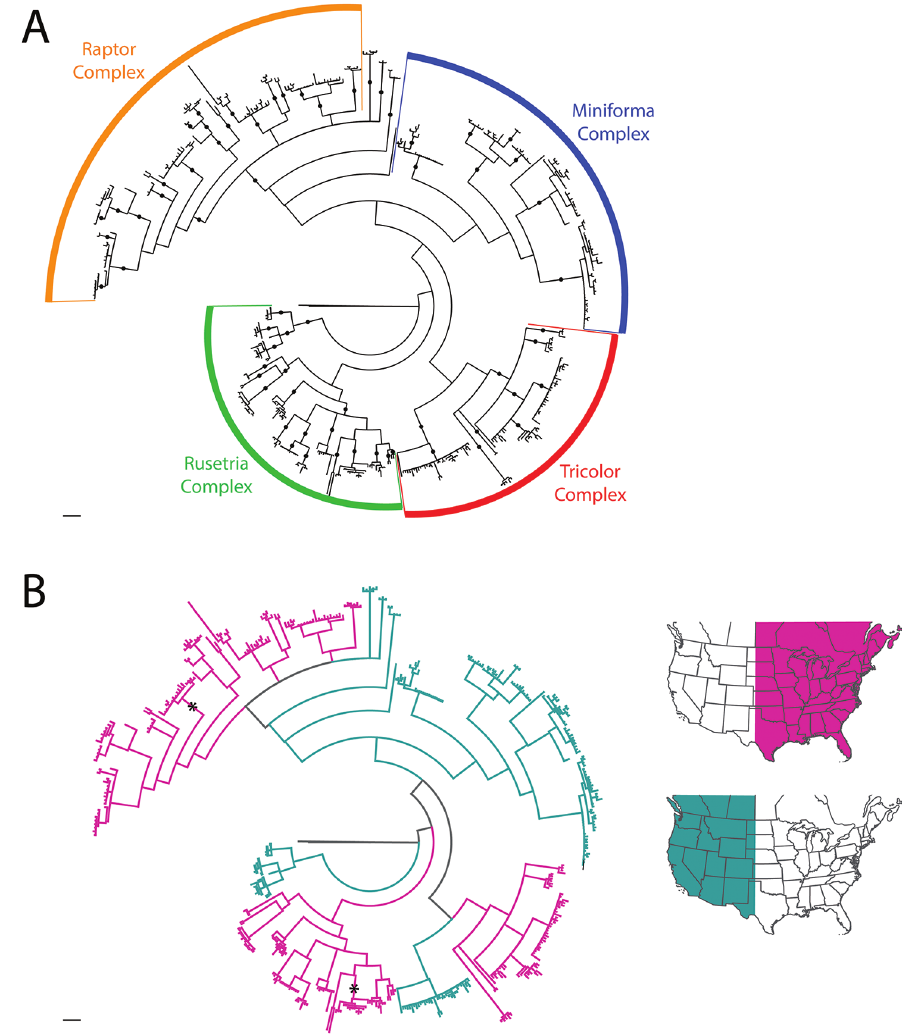
Figure 9. Bayesian inferred circular phylograms of North American Torrenticola , COI only. Scale bars indicate 1.0 substitutions per site. A Overall tree depicting the four complexes recovered in combined analysis. Dots denote posterior probability >95% B Species distributions; branch colors correspond to regions of North America depicted on the right (eastern, pink; western teal). Asterisks denote eastern spe- cies that extend into the west. Note that lineages tend to contain species distributed in either the east or west, but not both. Detail of this figure is presented in Figures